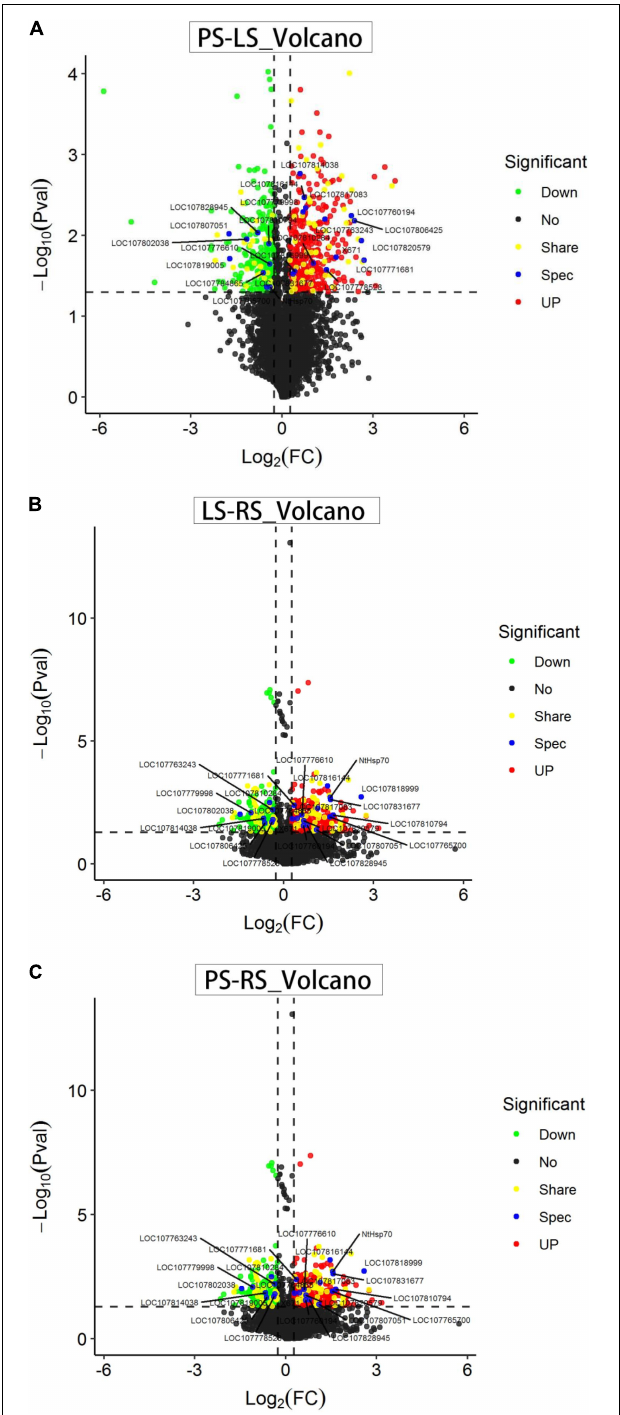
FIGURE 4 | Volcano plot showing the corrected values of p for the changes in the patterns of all identified proteins in pairwise comparisons. (A) Differentially abundant proteins (DAPs) in LS vs. PS; (B) DAPs in LS vs. RS; and (C) DAPs in PS vs. RS. Red indicates significantly upregulated proteins. Green indicates significantly downregulated proteins. Black indicates proteins whose levels did not significantly change. Yellow indicates significantly share-regulated proteins. Blue indicates significantly spec-regulated proteins.